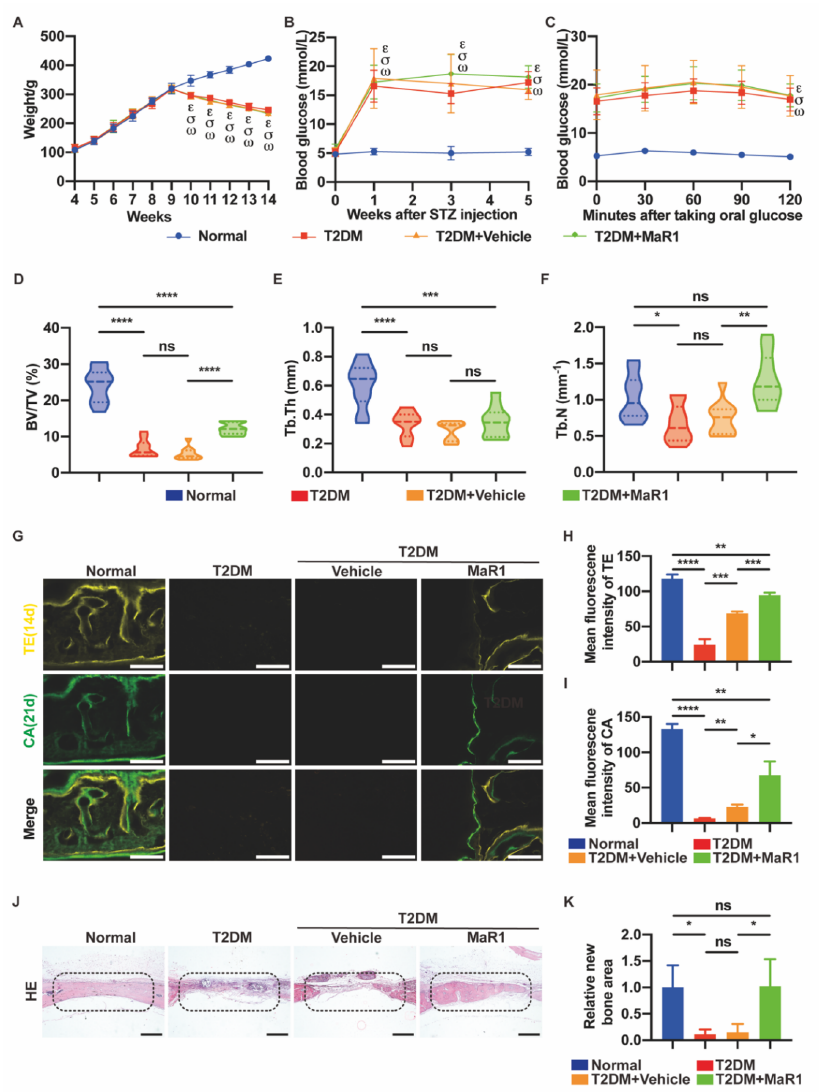
Figure 5. MaR1 promoted in situ bone regeneration in a calvarial defect model in diabetic rats. ( A ) Weight and ( B ) blood glucose in the four groups. ( C ) Fasting blood glucose levels after taking oral glucose in different experimental rats. ε : p < 0.05, for T2DM group vs. Normal group; σ : p < 0.05, for T2DM + Vehicle group vs. Normal group; ω : p < 0.05, for T2DM + MaR1 group vs. Normal group. ( D ) Three-dimensional reconstructed micro-CT of bilateral 5 mm rat calvarial defects was performed one month after surgery. Quantification analysis of BV/TV%, ( E ) Tb.Th mm, and ( F ) Tb.N mm − 1 using micro-computed tomography. ( G ) Bicolor fluorescent labeling in the hard tissue slicing of the rat skulls. TE, tetracycline (yellow); CA, calcein (green). Scale bar = 100 µ m. ( H ) A quantitative analysis of TE and ( I ) CA mean fluorescence intensity one month after surgery. ( J ) HE staining demonstrated the development of new bone in the defects. Black dotted frame: bone defect area. Scale bar = 500 µ m. ( K ) Quantification study of the new bone development region in HE staining. Defects with a 5 mm diameter were indicated by a black dotted frame. Data are presented as the means ± SDs; n = 3 specimens/group; ns p > 0.05; * p < 0.05, ** p < 0.01, *** p < 0.001, **** p < 0.0001. Normal: normal diet and citrate injection; T2DM: four-week high-carbohydrate, high-fat diet, with STZ intraperitoneal injection (30 mg/kg); T2DM + Vehicle: gelatin sponge was placed in the defect, and the rest were the same as the T2DM group; T2DM + MaR1: gelatin sponge soaked in MaR1 was placed in the defect, and the rest were the same as the T2DM group. BV, bone volume; TV, total volume; Tb.Th, thickness of trabecular bone; Tb.N, number of trabecular